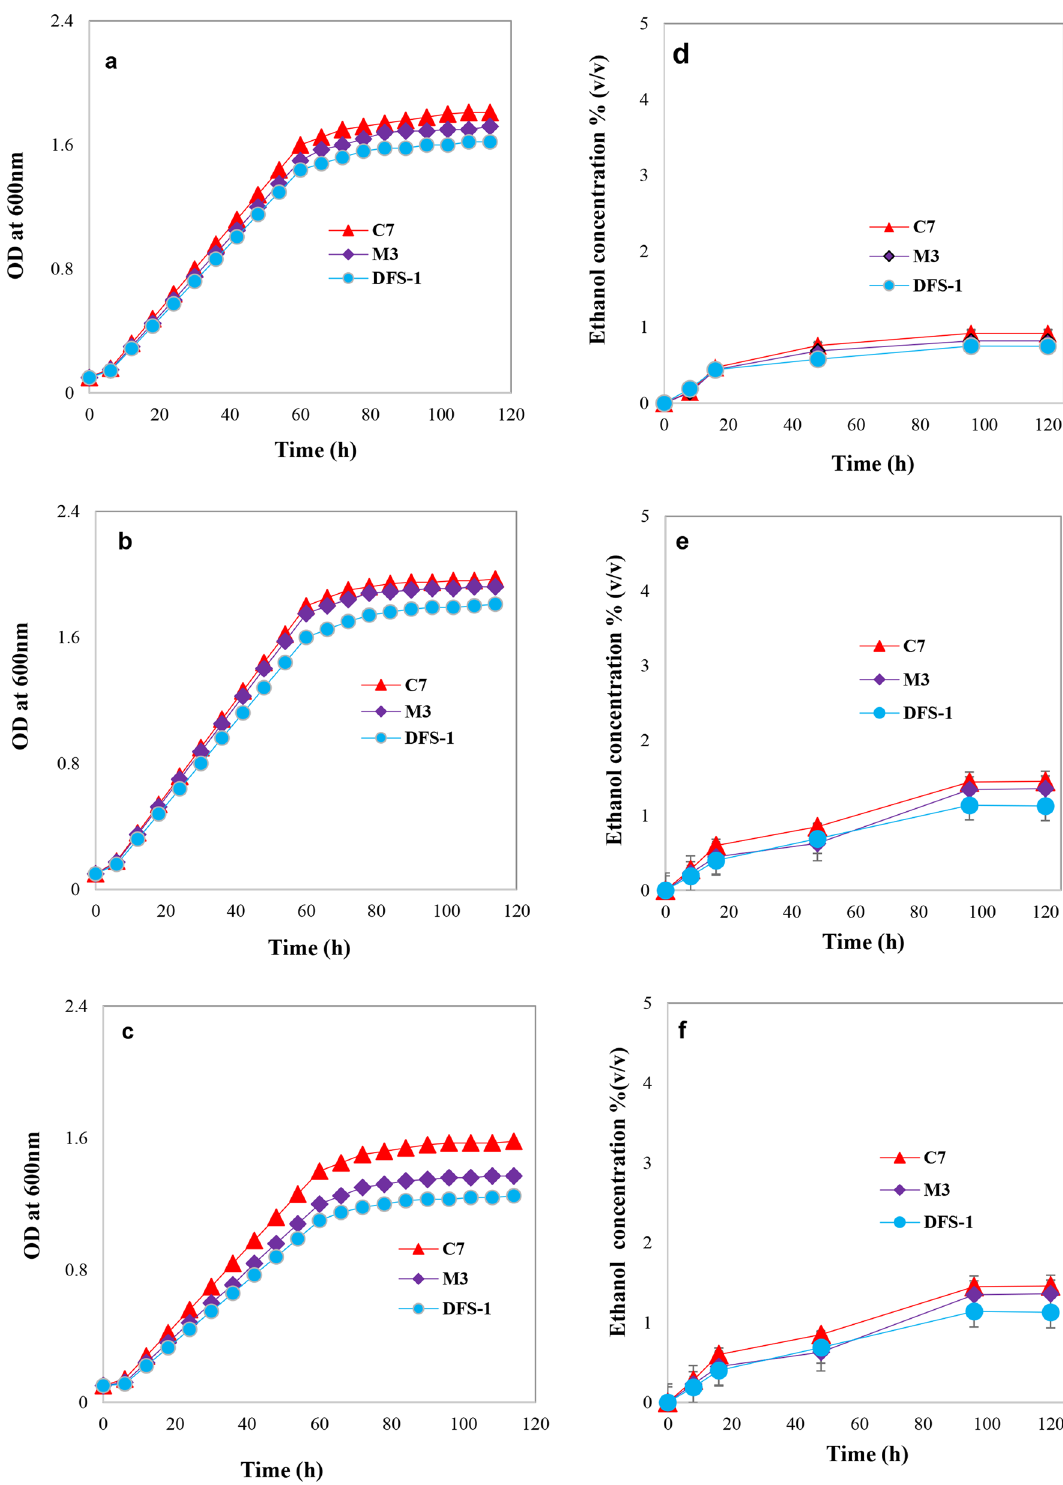
Figure 3. Growth pattern and their ethanol production capability (%) of selected strains from starch fermentation. Here ( a – c ) represent growth pattern, where ( d – f ) represents the ethanol production capability of selected strains from starch fermentation at 30 °C, 37 °C and 42 °C respectively. Samples were collected at 6-h intervals, put on an ice bucket to seize the growth. Subsequently, their growth was measured by a spectrophotometer at 600 nm against the YPS broth as blank. For ethanol concentration measurement, samples were taken at 8 h, 16 h, 48 h, 96 h and 120 h intervals from starch fermentation broth